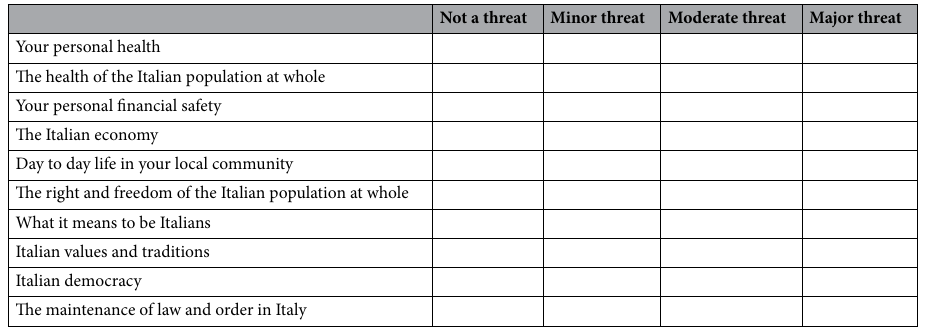
Table 1. The integrated COVID-19 36 threat scale adapted to Italy. Indicate how threatened you feel by the impact of COVID 19 on the aspects listed.